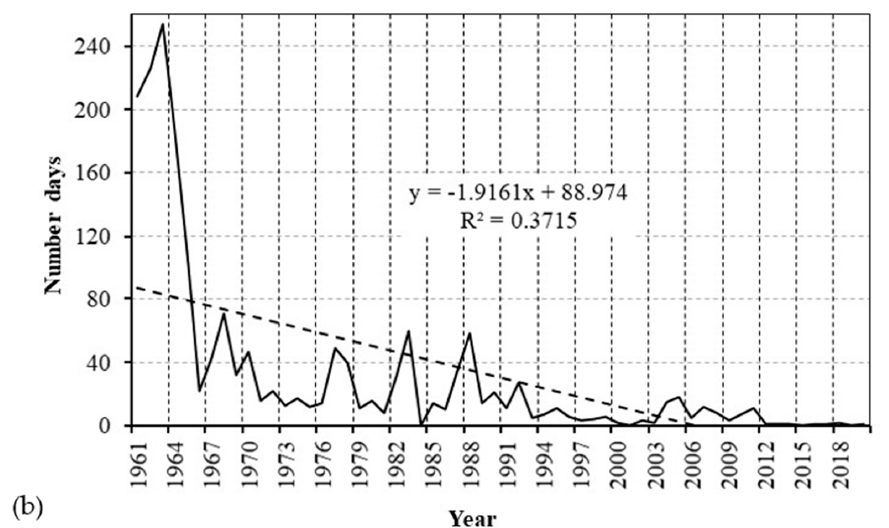
Figure 4. Number days of mean sea level >210 cm ( a ) and mean sea level <170 cm ( b ) at the Hon Dau station (1961–2020).